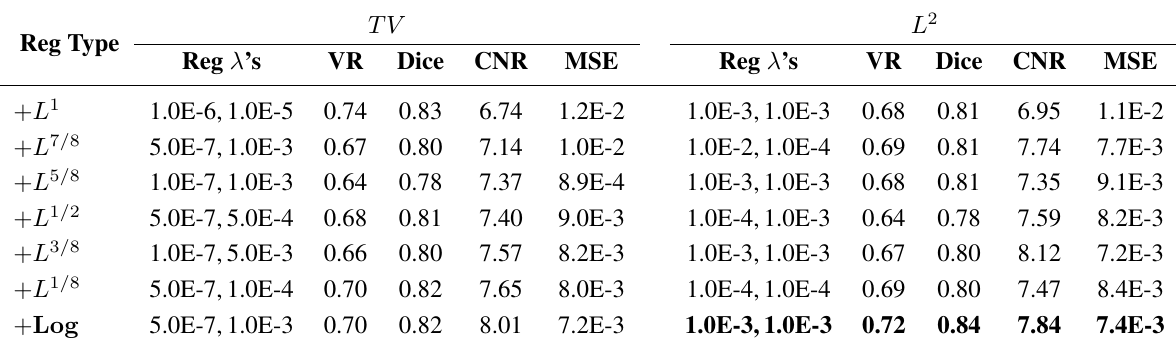
Table 4. Metrics of the best reconstructed images using combined regularizations for simulated large target, with the best regularization method highlighted in bold.